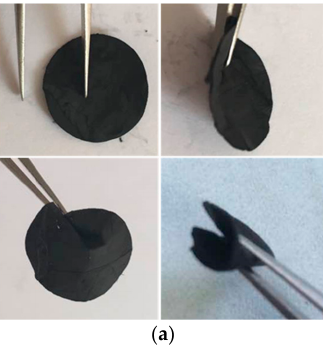
Figure 1. ATR-FTIR spectra of polyacrylic acid (PAA) and modified polyacrylic acid